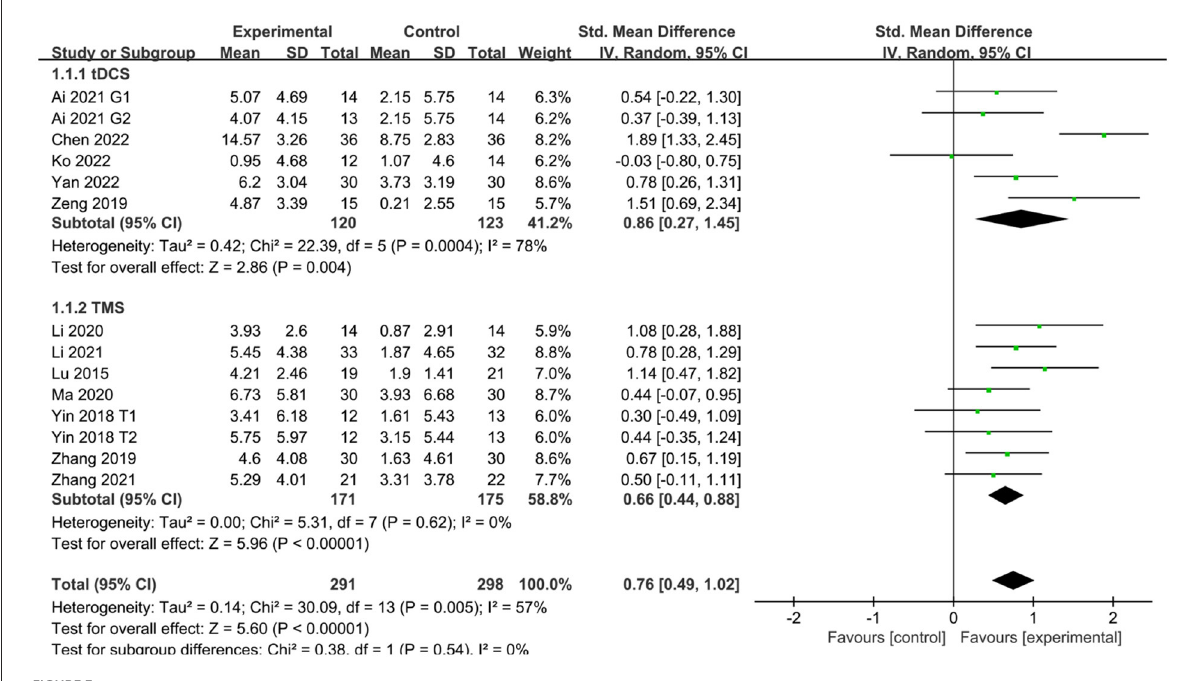
FIGURE3 Effect of NIBS on MoCA score in PSCI